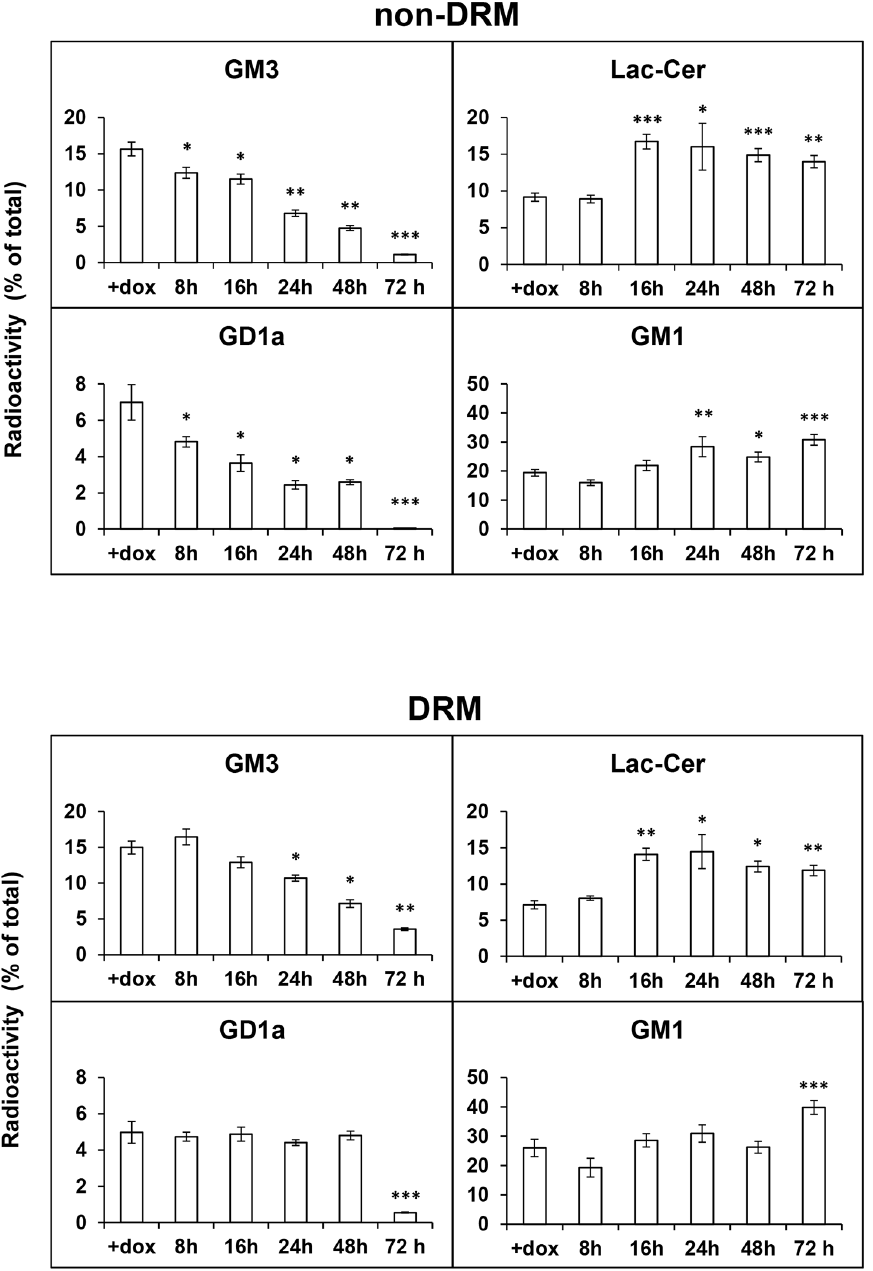
Figure 4. NEU3-HA-GFP specifically modifies the ganglioside pattern of non-DRM and DRM. OFF HeLa tTA2 NEU3-HA-GFP cells were metabolically labeled for 2 h with [ 3 H]Sphingosine and, after a 24 h chase, dox was removed for the indicated time periods. Cells were then extracted in the appropriate buffer containing 1% Triton X-100 for 30 min at 4 u C. non-DRM (upper panel) and DRM (lower panel) were separated by Opti-Prep density gradient centrifugation. Equal aliquots of fractions 2 and 3 (DRM) and of fractions 6, 7 and 8 (non-DRM) were pooled and gangliosides and non-ganglioside sphingolipids were extracted, separated and quantified. Values are given as percentage of total and represent the means 6 S.D. of 3 independent experiments. *p , 0.05; **p , 0.01; ***p , 0.001. promoter were established. This cell model shared the same characteristics described for the HeLa tTA2 NEU3-HA-GFP model, i.e. expression of the chimera protein is strictly dependent on the absence of dox in the growth medium with a 1.5 higher specific activity and, biosynthesis and degradation followed the same kinetics described for the chimera NEU3-HA-GFP.